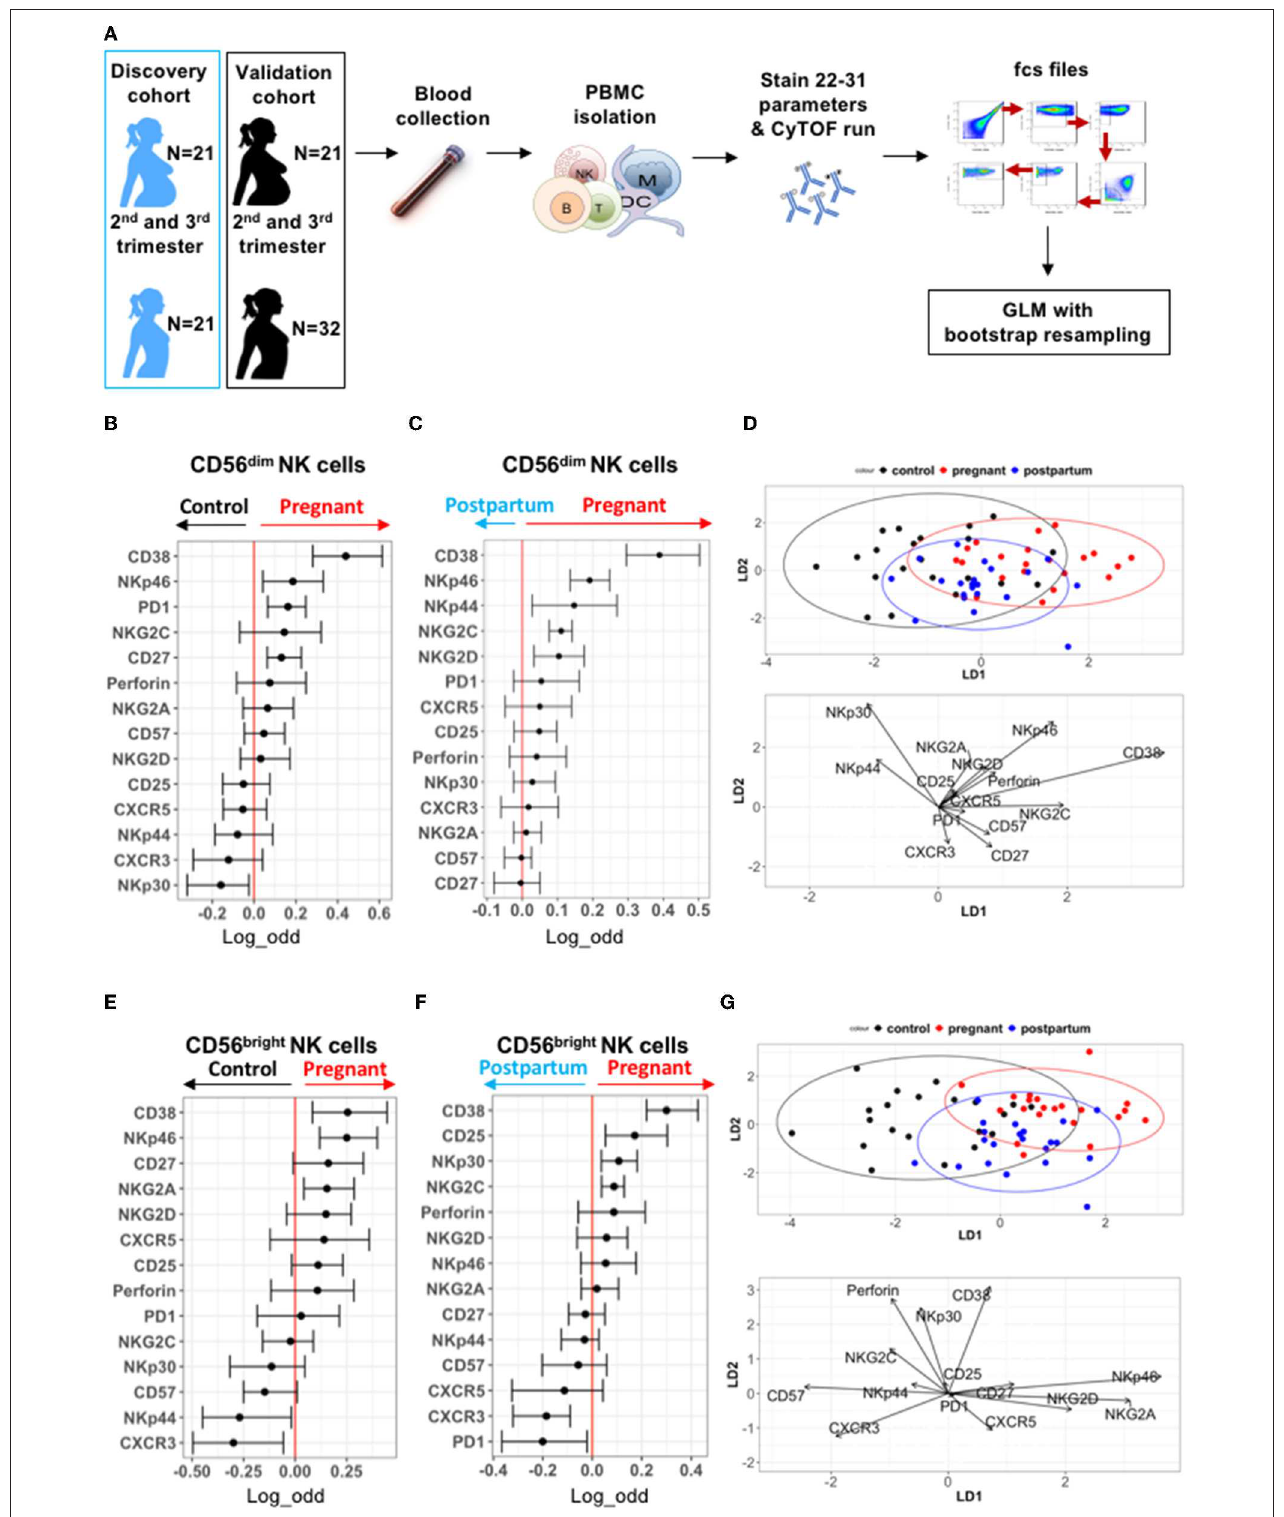
FIGURE 2 | Deep profiling of CD56 dim and CD56 bright NK cells in non-pregnant and pregnant women from discovery cohort. (A) PBMCs from controls ( N = 21), pregnant women ( N = 21), and post-partum women ( N = 21) in discovery cohort were isolated from blood samples. PBMCs were isolated and stained for